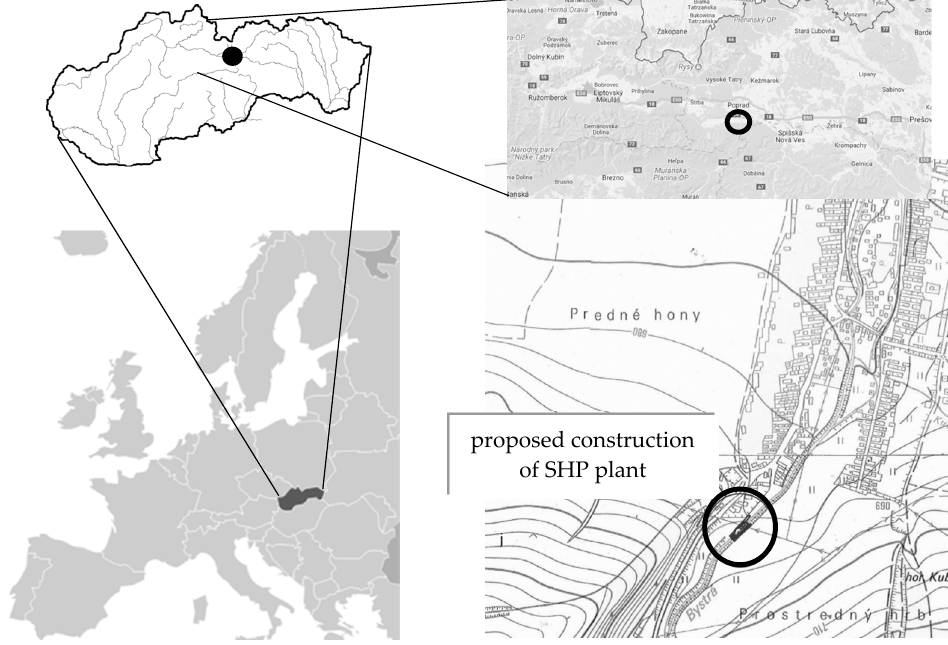
Figure 1. Location of the study area. SHP: small hydropower.